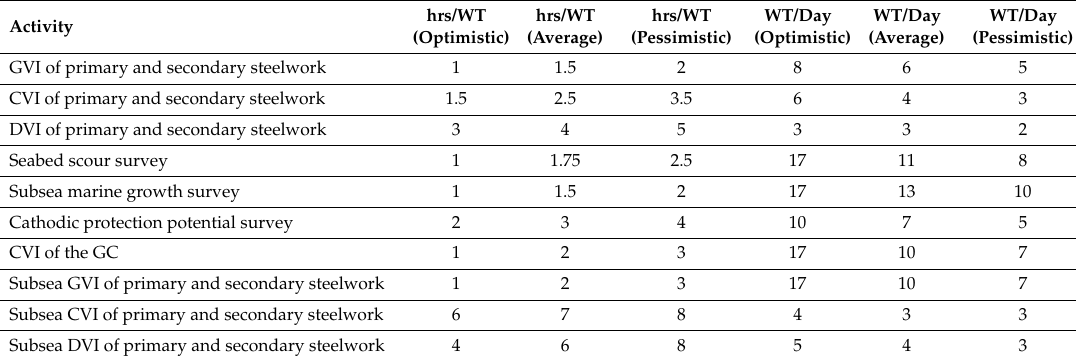
Table 15. Sensitivity analysis of inspection